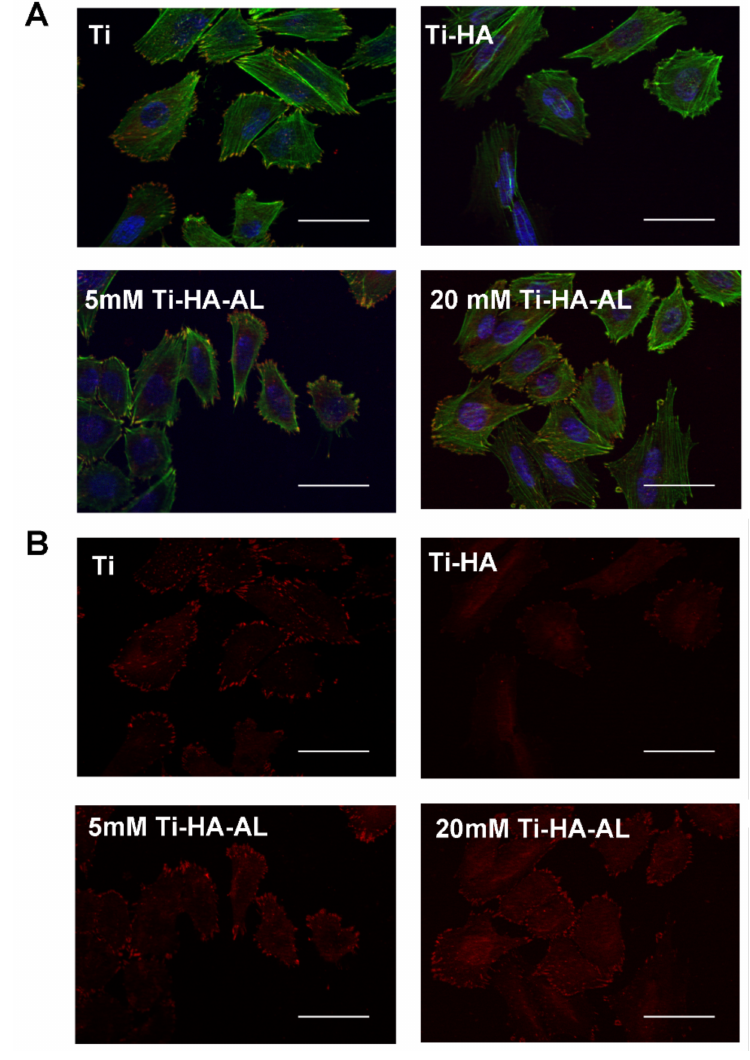
Figure 7. Immunofluorescence images of SaOs2 cells adhesion to biomaterials: actin (green) was labeled with Alexa Fluor 488 conjugated phalloidin, and vinculin was firstly labeled with primary antibodies and then with secondary antibodies conjugated with Alexa Fluor 594 (red); the nuclei are labeled with DAPI (blue) for cell identification. ( A )—merged 3-channel images showing the distribution of cytoskeleton and focal adhesions; ( B )—single channel images showing vinculin staining of focal adhesions. Scale bar = 50 µ